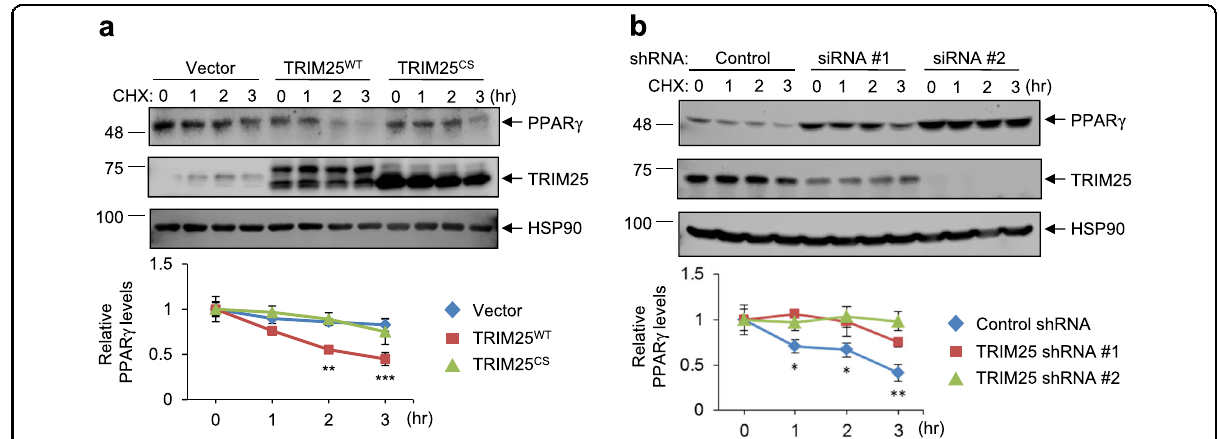
Fig. 3 TRIM25 destabilizes PPAR γ . HCT116 cells were transfected with TRIM25 WT and TRIM25 CS ( a ) or siRNAs against TRIM25 (#1 and #2) ( b ) in the presence or absence of CHX (50 μ g/ml for the indicated time). The indicated proteins were measured by western blotting. Relative PPAR γ protein levels were measured using ImageJ (bottom